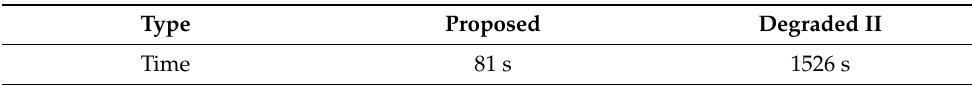
Table 5. Comparison of running time of dynamic iterative modules between the proposed model and the Degraded I model.